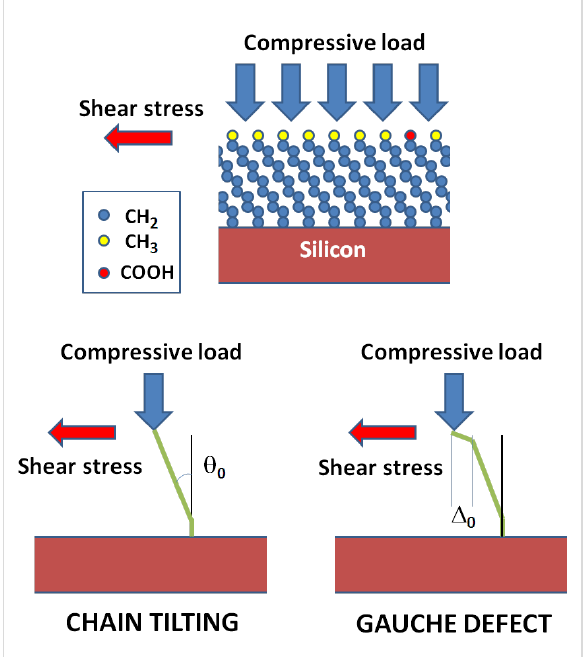
Figure 1: Top: the electrostatic pressure resulting from a dc voltage drop on the insulating molecular monolayer is described by a normal compressive load. Bottom: the mechanical response to the induced shear stress may lead to global chain axis tilting (left panel) or forma- tion of gauche defects preferentially localized at chain ends (right